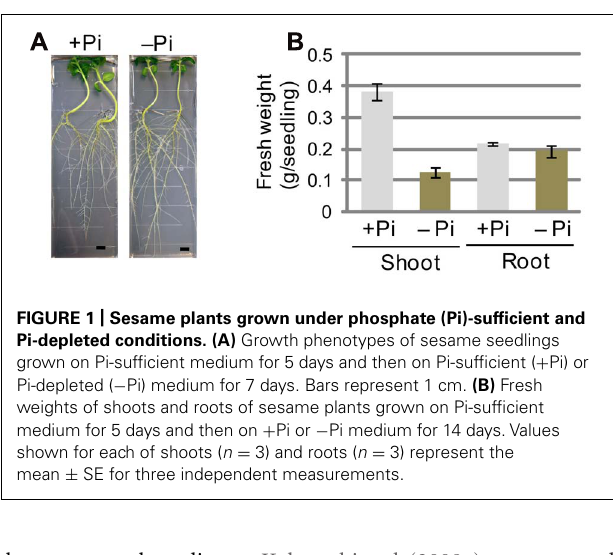
thesamegrowthmediumasKobayashiet al.(2009a),wecompared the sesame phenotype with their Arabidopsis data.